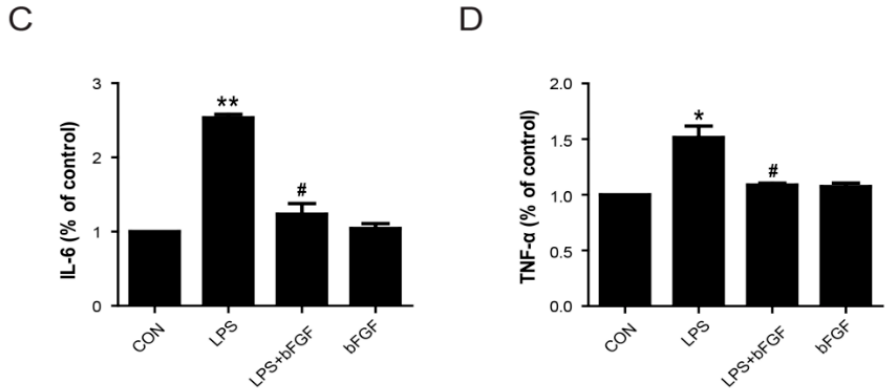
Figure 5. Effect of bFGF on inflammatory cytokine expression and secretion in astrocytes that were induced by LPS. Cells were incubated in the presence of LPS (2 µg/mL) with or without bFGF (100 ng/mL) for 24 h. Cells and supernatants were collected for experiments. ( A ) Western blot of IL-6 and densitometric analyses; ( B ) Western blot of TNF- α and densitometric analyses; ( C ) ELISA of IL-6; ( D ) ELISA of TNF- α . * p < 0.05, ** p < 0.01 versus CON, # p < 0.05 versus LPS. All results represent at least three independent experiments.